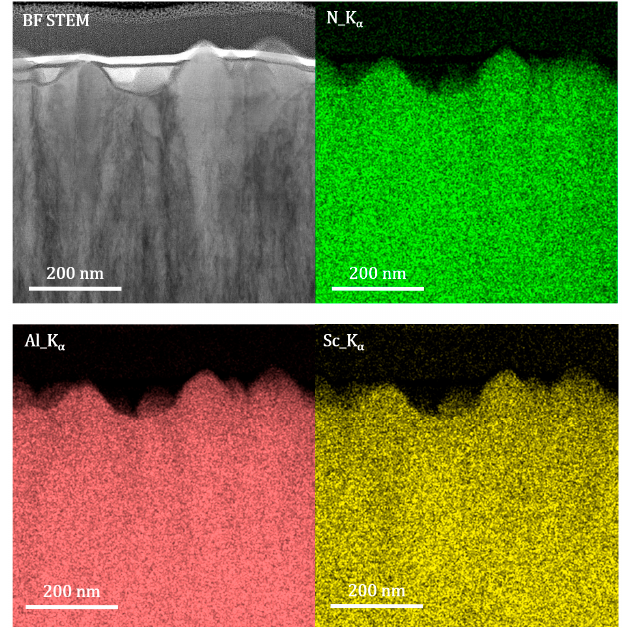
Figure 5. STEM-EDS mapping of the Sc 0.18 Al 0.82 N thin film: N (green), Al (red) and Sc (yellow).